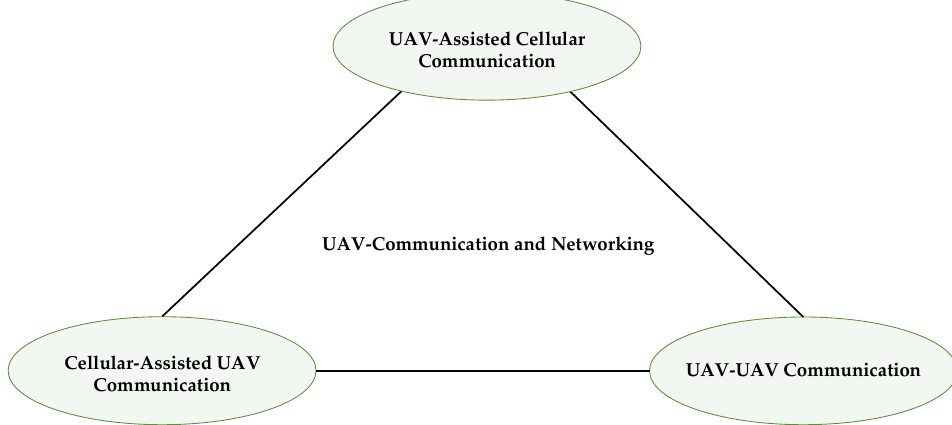
Figure 2. Drones and cellular network integration opportunities.